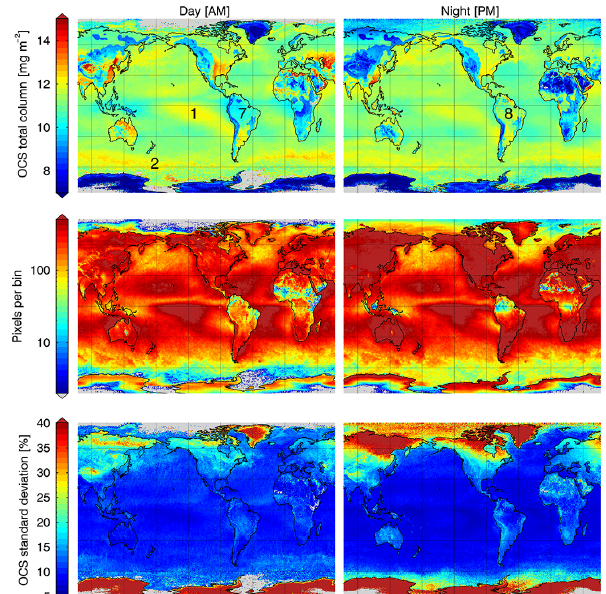
Figure 15. Same as in Fig. 10, but for November–December 2014.